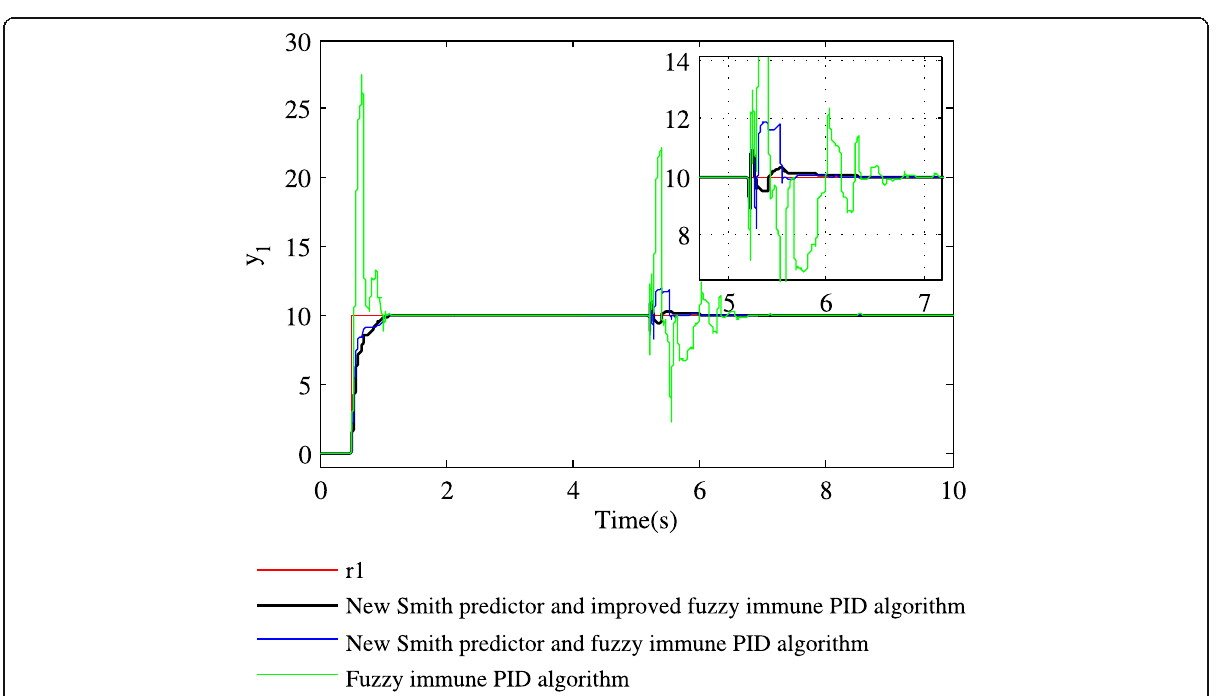
Fig. 15 The step responses of loop 1 when parameter perturbation and communication network change